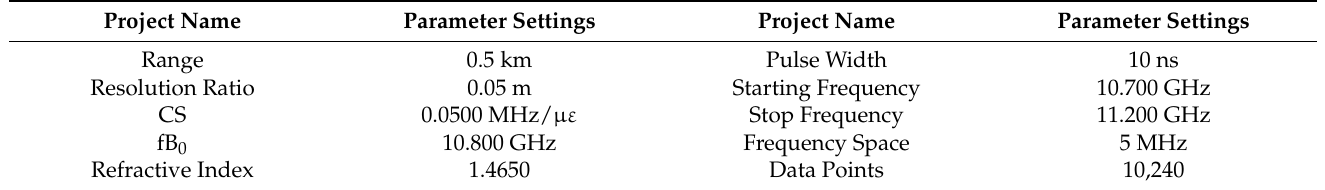
Table 2. Parameters of acquisition